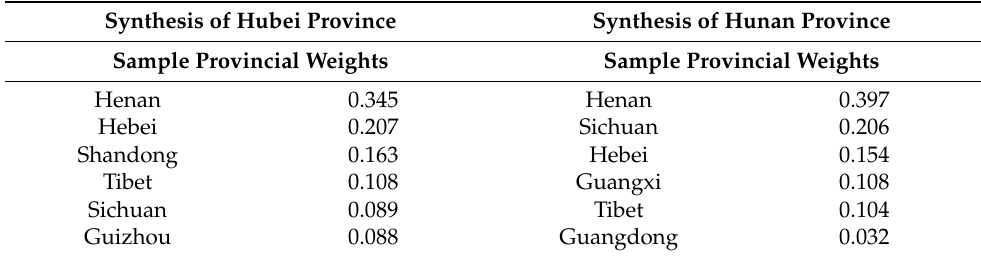
Table 3. Nonzero weights of samples for total emissions of synthetic general industrial solid waste.